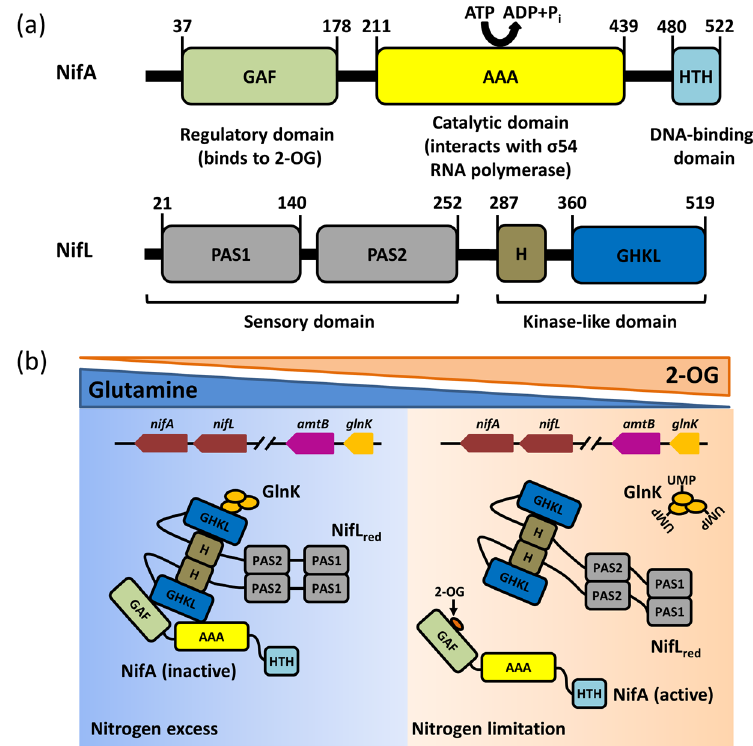
Figure 2. The domain structures and functions of NifA and NifL. ( a ) Schemes of the domain structures of the NifA and NifL protein; ( b ) The distinct regulatory modes of NifA–NifL–GlnK complex in the excess or limitation of nitrogen. In nitrogen excess, GHKL domain of NifL protein interacts with NifA protein to inhibit NifA. Glnk can interact with NifL, enhancing the inhibition of NifA activity by NifL. When nitrogen is limited, the uridylylation of Glnk disrupts the interaction between Glnk and NifL. 2 – OG can bind to GAF domain of NifA to remove the inhibition of NifA activity by NifL.